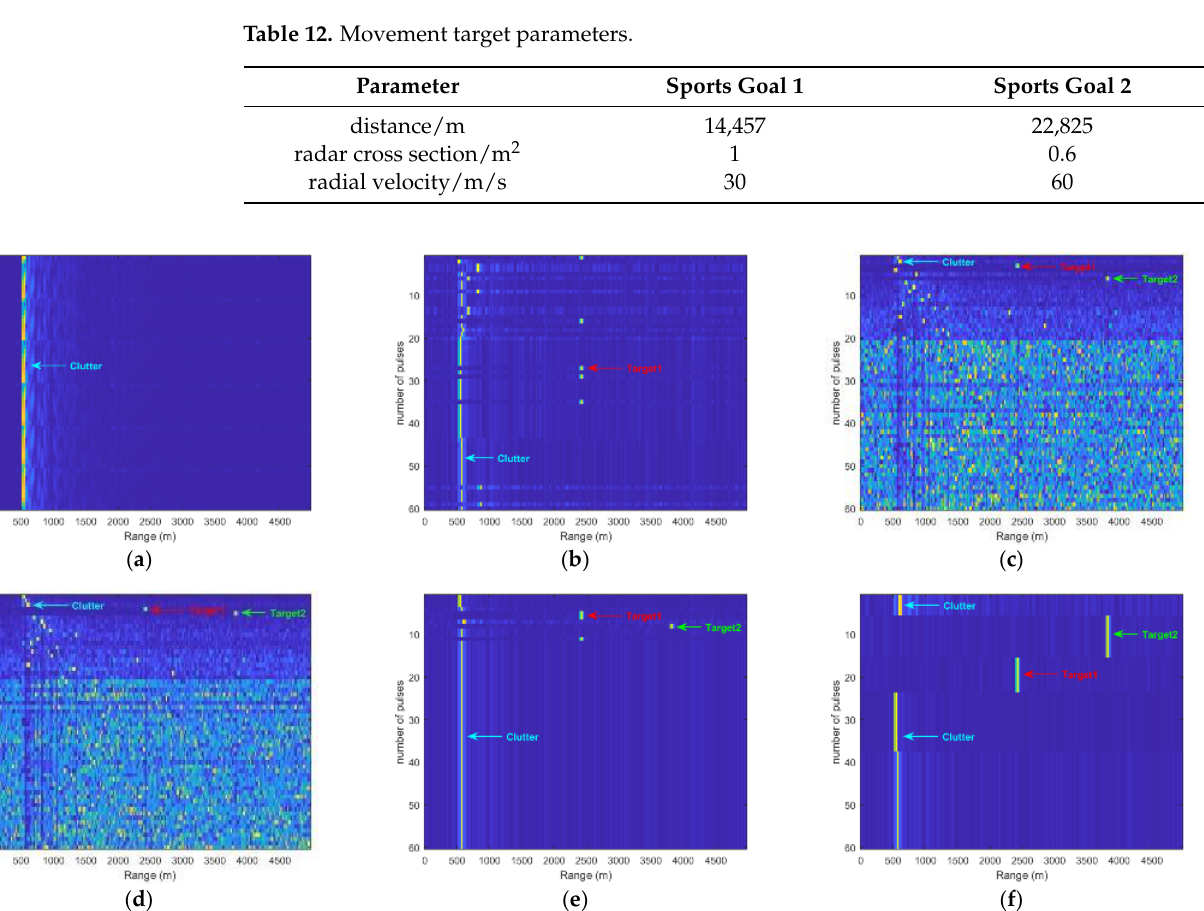
Figure 12. The BSS results for FastICA, PSA, MPSA, NPSA, and PPSA. ( a ) Echo data, ( b ) the result of FastICA, ( c ) the result of PSA, ( d ) the result of MPSA, ( e ) the result of NPSA, ( f ) the result of PPSA. Table 13. Running time evaluation of BSS Algorithm.